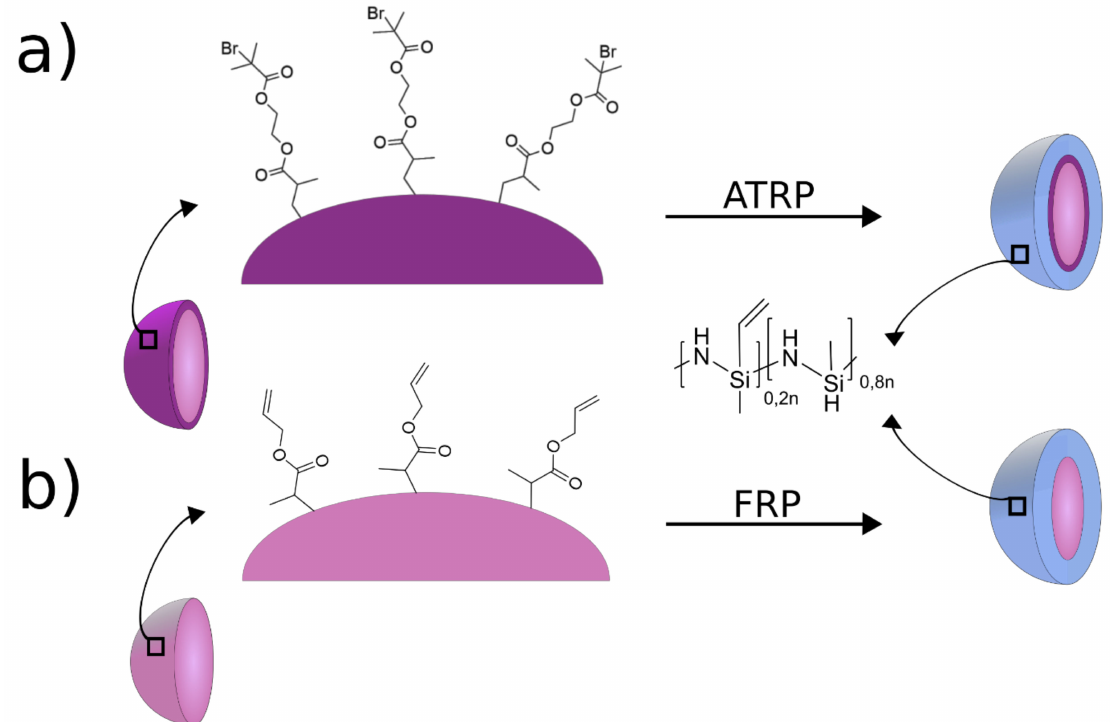
Figure 1. Functional groups on the particle surface of synthesized monodisperse colloids for the binding of polysilazane via atom transfer radical polymerization (ATRP) ( a ) and free radical polymerization (FRP) ( b